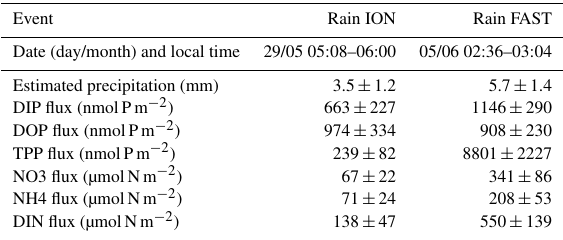
Table 3. Characteristics and nutrient fluxes estimated in the two rain samples collected during the PEACETIME cruise at ION and